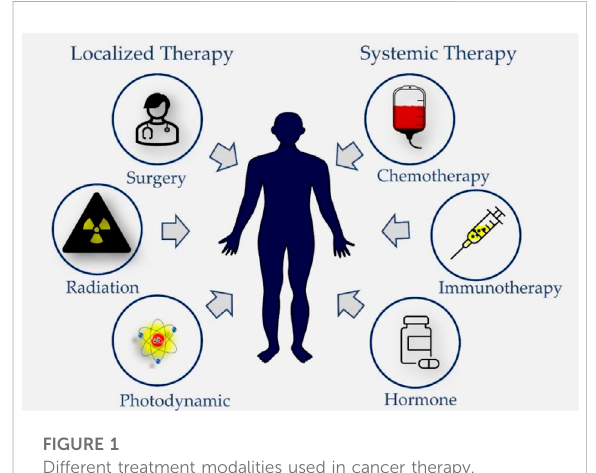
FIGURE 1 Different treatment modalities used in cancer therapy.